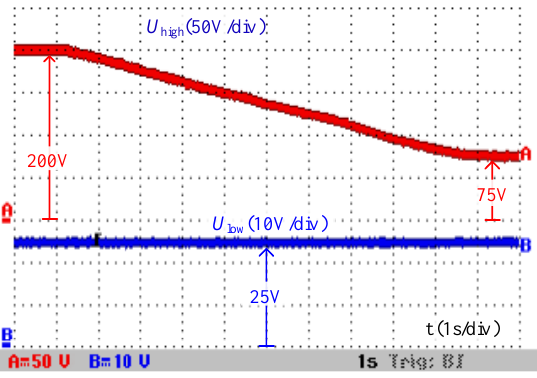
Figure 20. The output voltage and the wide-range changed input voltage from 200 V to 75 V in step- down mode.